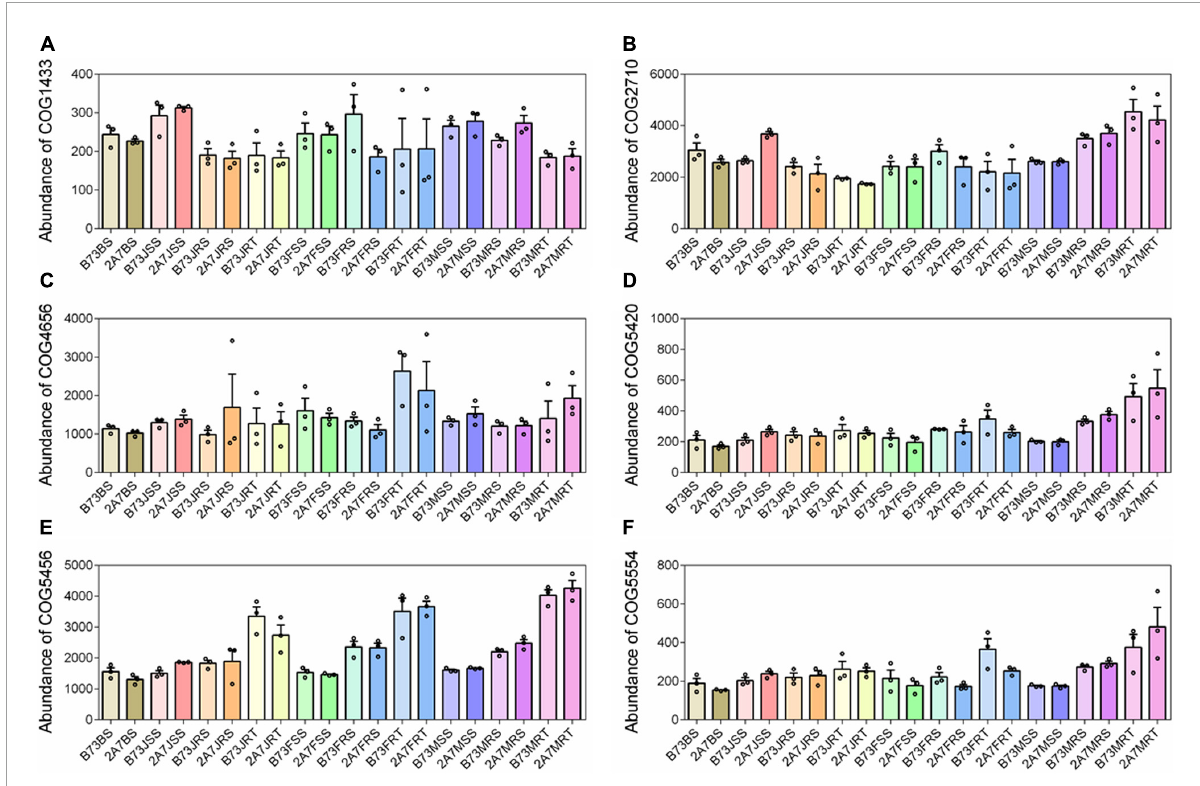
FIGURE5 The relative abundance of COG function classification which were directly related to nitrogen-fixation. The six COGs from (A–F) were described as dinitrogenase iron-molybdenum cofactor biosynthesis protein (A) , nitrogenase (B) , required for nitrogen fixation (C) , nitrogen fixation (D) , nitrogen fixation protein FixH (E) , and nitrogen fixation protein (F) , respectively. Treatment’s details were as in Figure 2